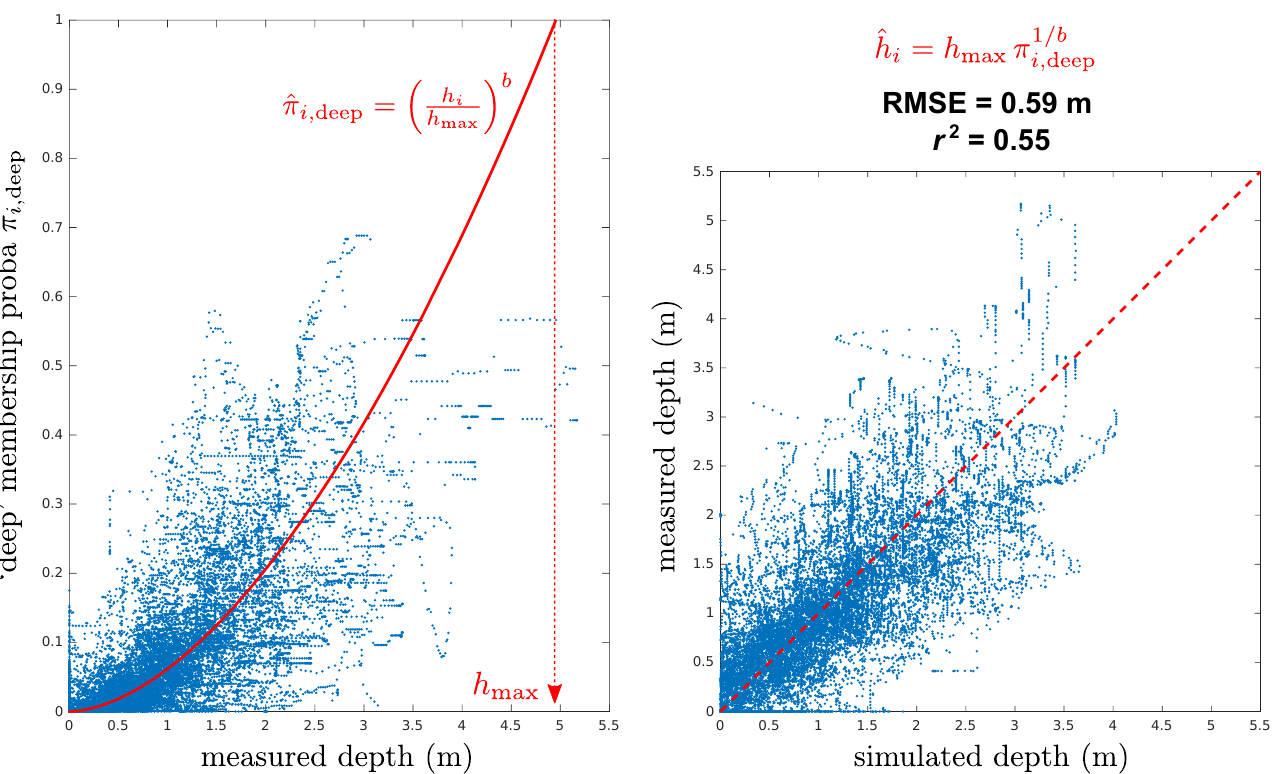
Figure 13. ( Left panel ): ‘depth’ vs. ‘deep membership probability’ regression as outputted by the modified expectation– maximization. This relation is of course meant to be used in the reverse direction in predictive mode ( right panel ): given the posterior membership probability π i ,deep computed at pixel i with multispectral hue U i , we can estimate depth h i at this